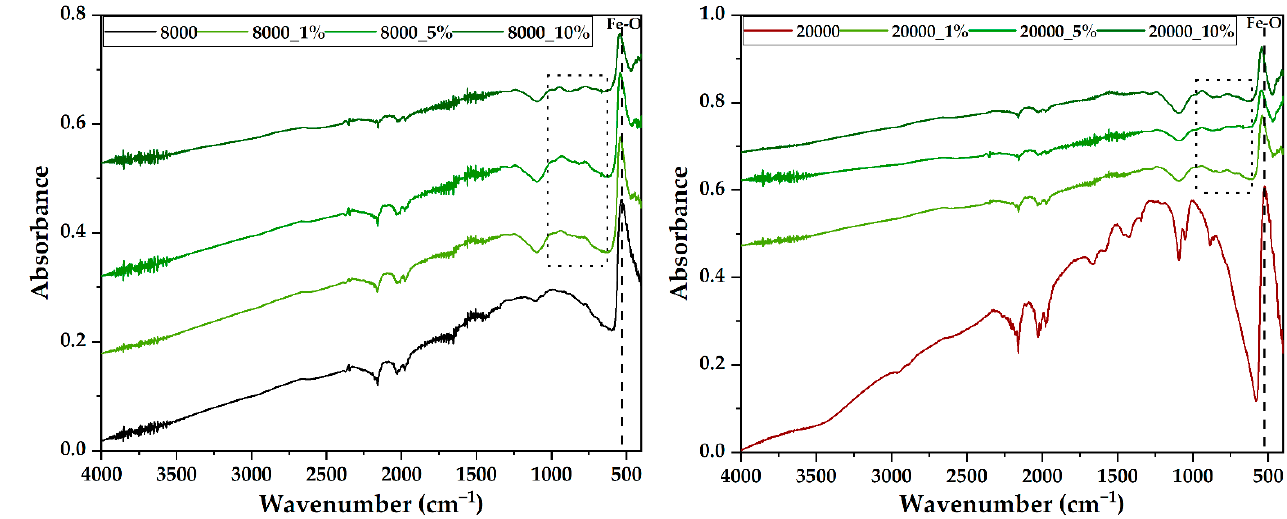
Figure 5. FT-IR spectra of the two types of magnetite microspheres (8000— left and 20000— right ), both pristine and RA-loaded (marked square—the area of the RA fingerprint).